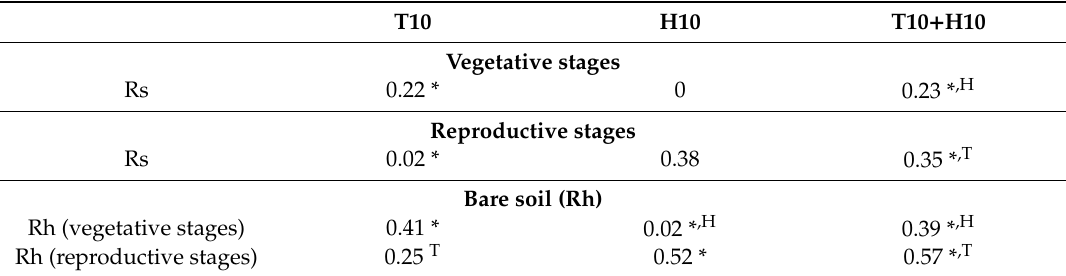
Table 8. Coe ffi cients of determination (R adj2 ) of the simple and multiple linear regression models between soil respiration(Rs) and soil temperature (T10) and soil moisture (H10) at 10 cm depth for both years for the vegetative ( n = 22) and reproductive stages ( n = 18) and R adj2 of the simple and multiple linear regression models between Rs in bare soil (Rh) and T10 and H10 for 2012 and 2013, for the vegetative ( n = 11) and reproductive stages ( n = 9) separately in a rainfed barley ( Hordeum vulgare L.) in Madrid,